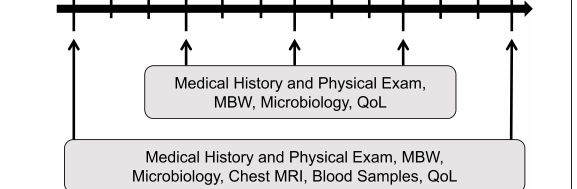
FIGURE2 TRACK-CF study design. Exemplary scheme for the first year following diagnosis. Black arrows indicate quarterly routine visits at the CF center; gray arrows indicate study visits performed as telephone interviews in months without a visit to the CF center. This assessment routine is repeated each year. CF, cystic fibrosis; QoL, quality of life questionnaire; MBW, multiple-breath washout; MRI, magnetic resonance